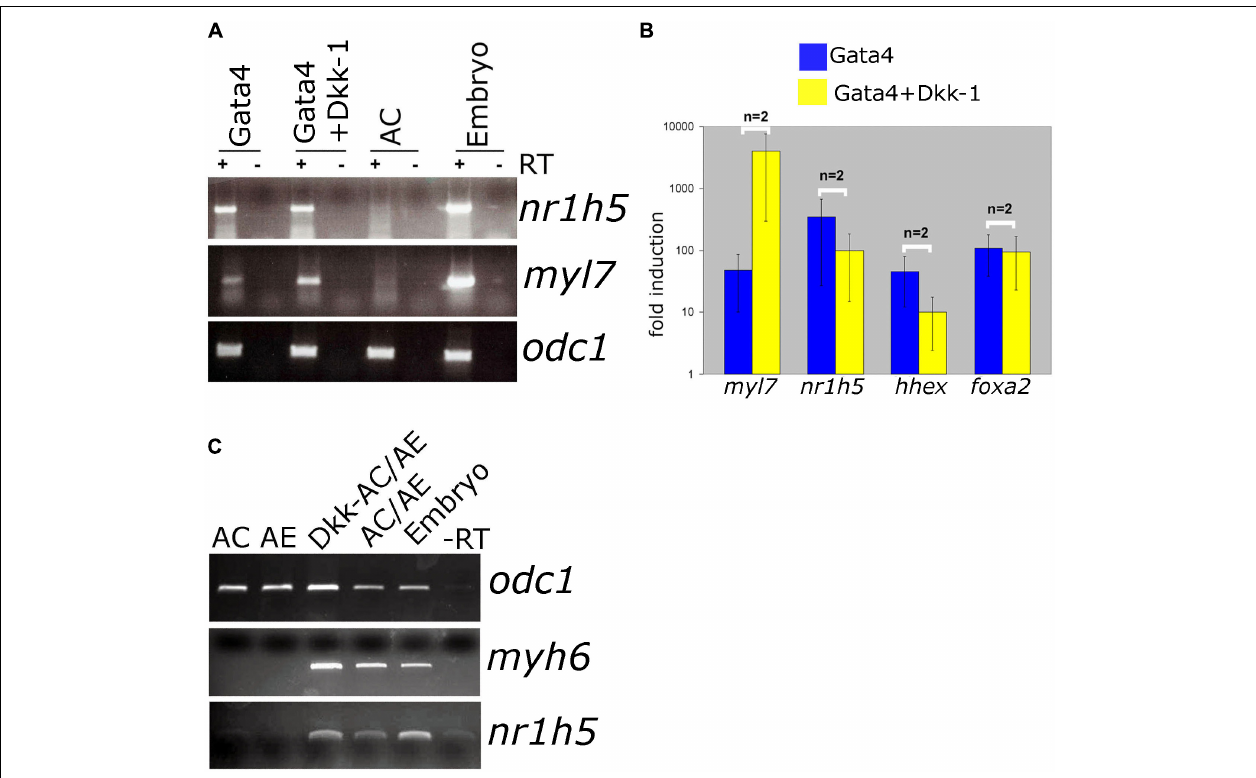
FIGURE 5 | Wnt/ β -catenin signaling is not required for liver specification in Gata4-AC and AC/AE. (A) Gata4 and dkk-1 mRNA co-injection in animal pole explants causes a well-described increase in cardiac marker levels but has no effect on nr1h5 . (B) qPCR analysis confirms these findings and extends them by showing no significant effect on hhex and foxa2 . (C) dkk-1 expression in AC/AE (injected in AC) likewise has no effect on nr1h5 . RT-PCR analyses were performed on st. 34 explants and sibling embryo controls.